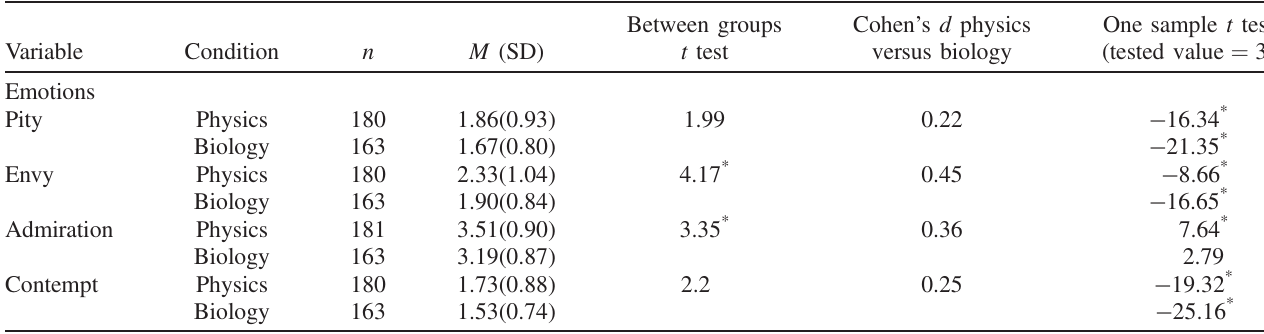
TABLE IV. Descriptive statistics and t -test values for emotions.